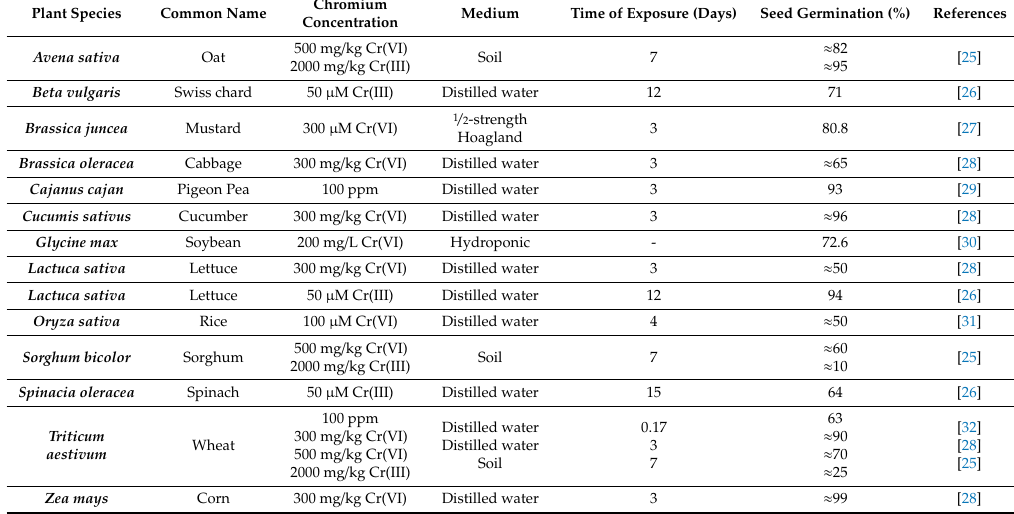
Table 1. Chromium-induced seed germination inhibition in various plant